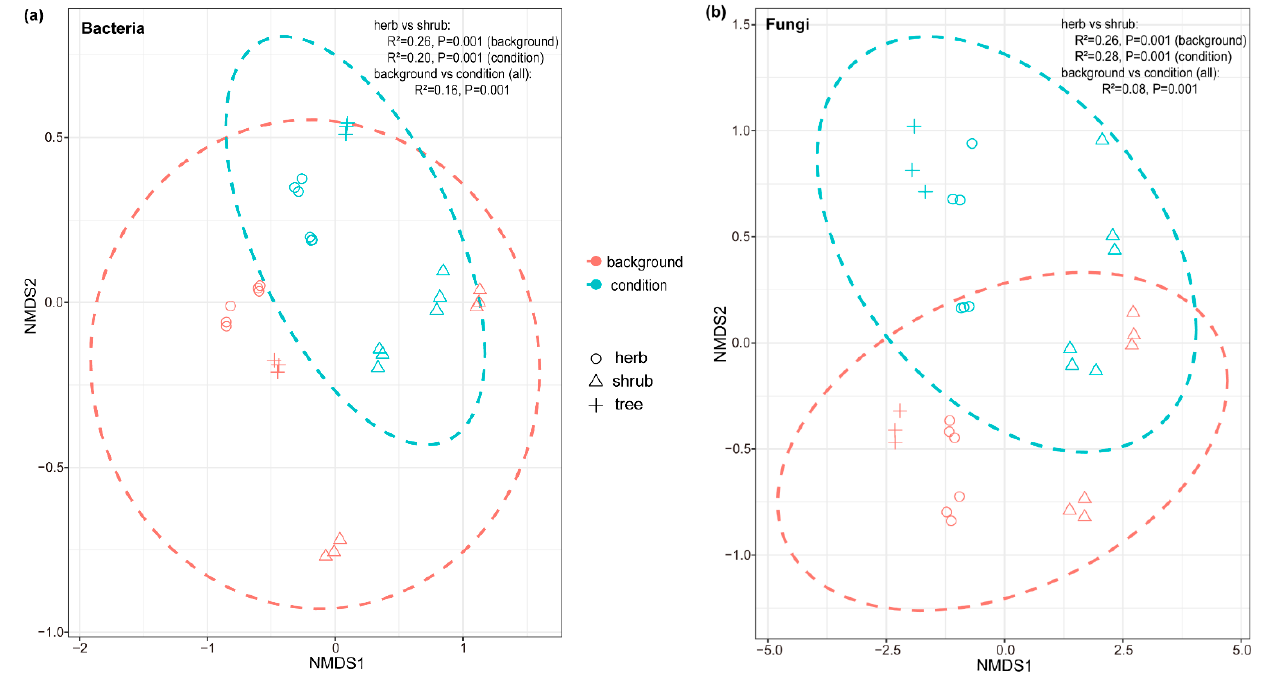
Figure 3. ( a ) Bacterial (stress = 0.081) and ( b ) fungal (stress = 0.079) communities of background (inoculum) and conditioned soils. NMDS using Bray–Curtis distance of background (inoculum) soils and conditioning plants (colors: blue depicts conditioned soils, red depicts background soils) and differential successional stages (shapes: circles represent herbs, triangles represent shrubs, and crosses represent trees). PERMANOVA results, including R 2 and significance p for the model, are given in the figure.